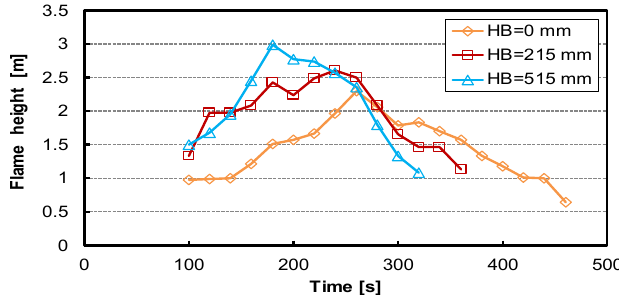
Figure 5. Experimental results of the average flame height.